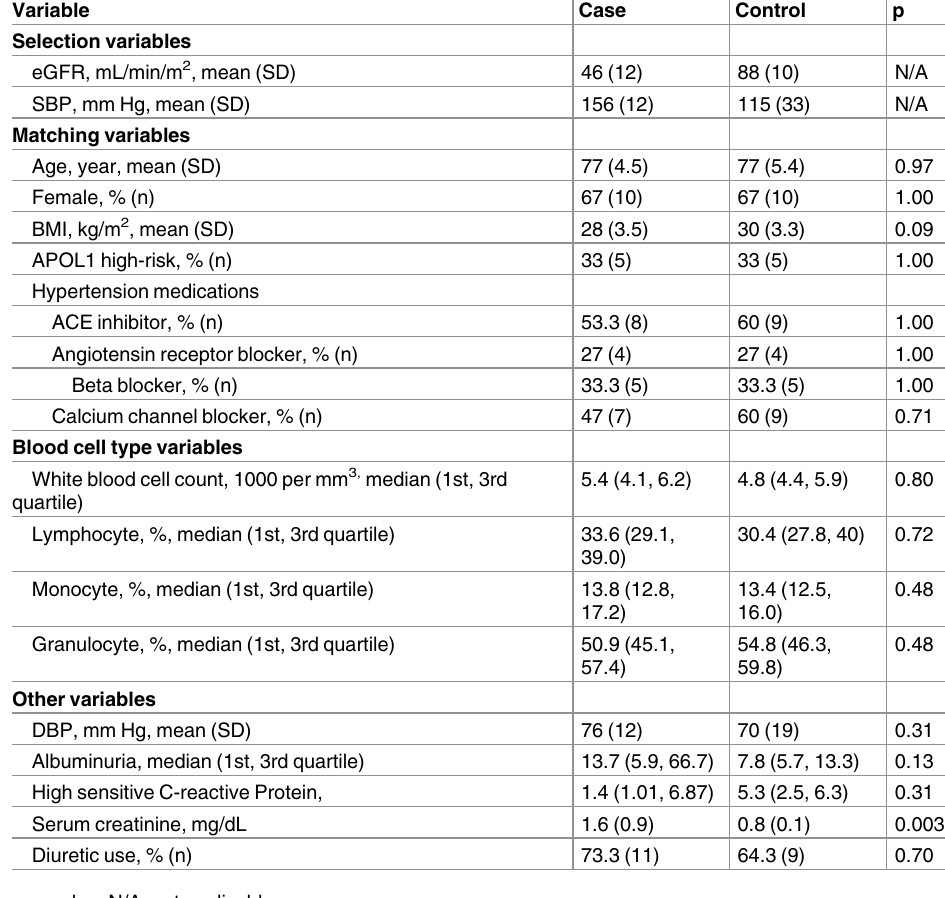
Table 1. Study population